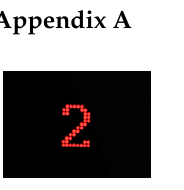
Figure A1. Display panel in the elevator car that shows the elevator reaching and leaving the second floor.